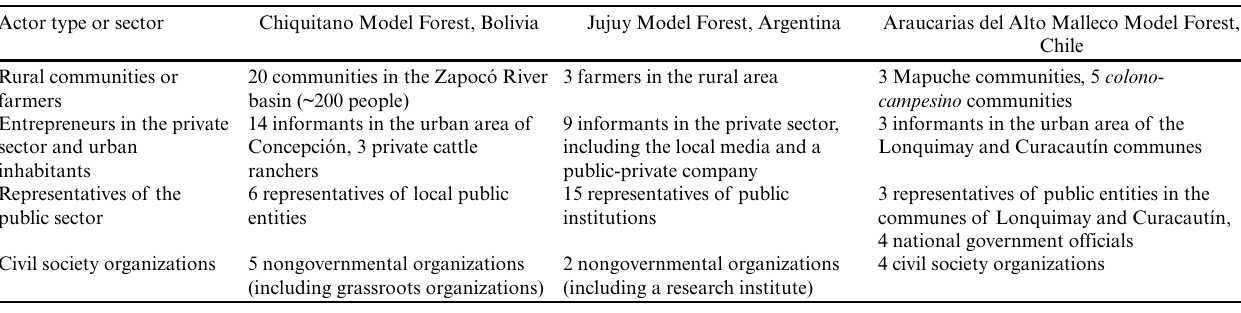
Table 1. Number and type of informants interviewed in each case study site. Actor type or